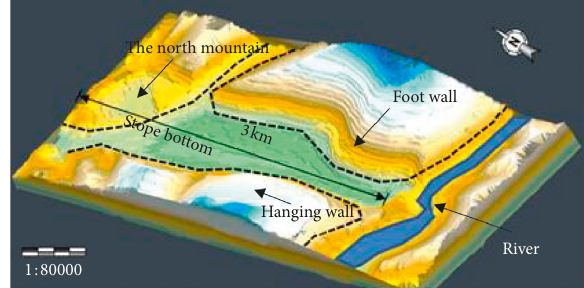
Figure 7: Mine mining site shape and landform.